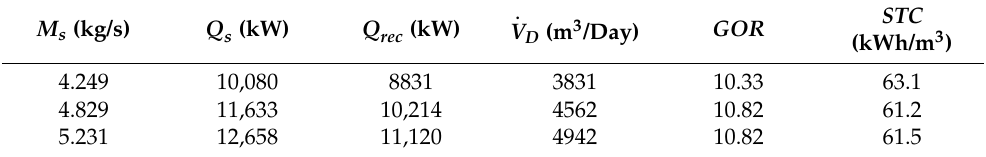
Table 11. Results for the LT-MED